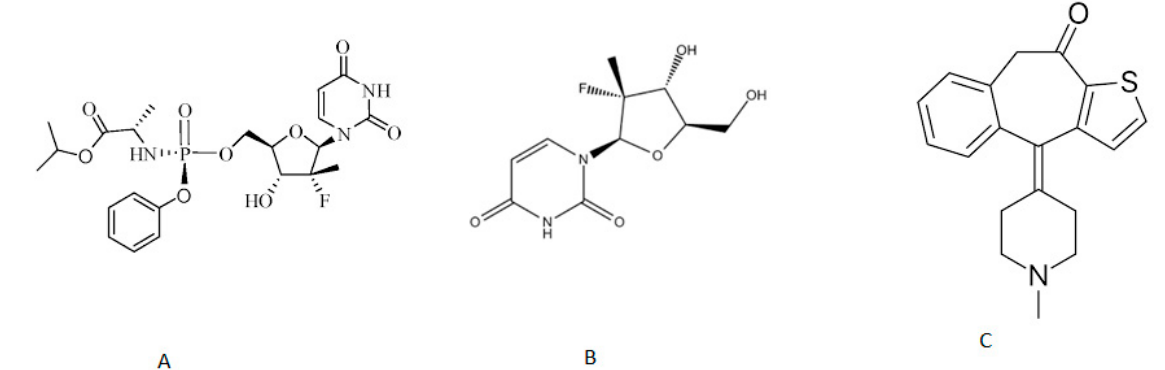
Figure 1. The chemical structures of sofosbuvir ( A ), GS331007 ( B ) and ketotifen (IS) ( C ).